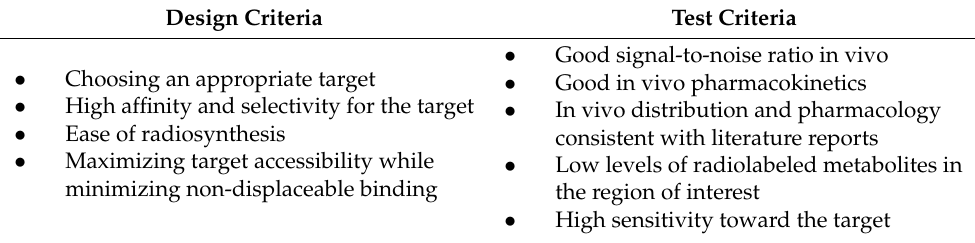
Table 1. Design and test criteria for the discovery and development of small molecule radiotracers [36]. Design